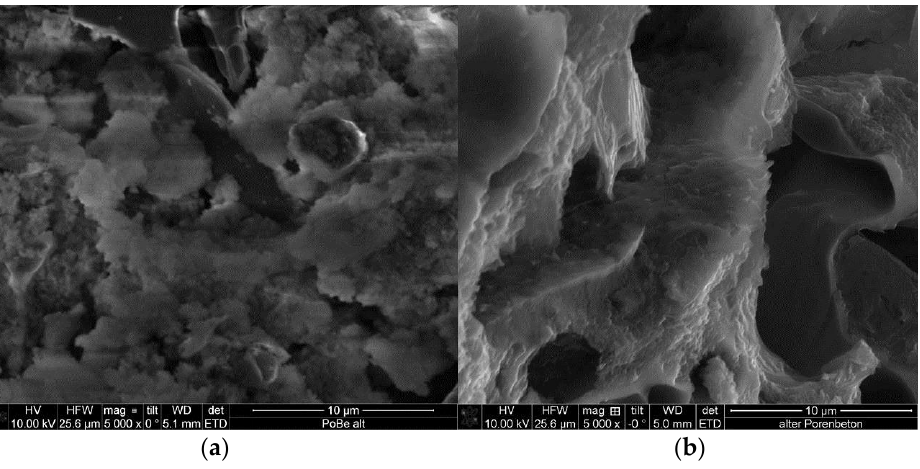
Figure 4. SEM photograph of porous concrete ( a ) and an according carbon replica (carbonized at 873 K) ( b ).